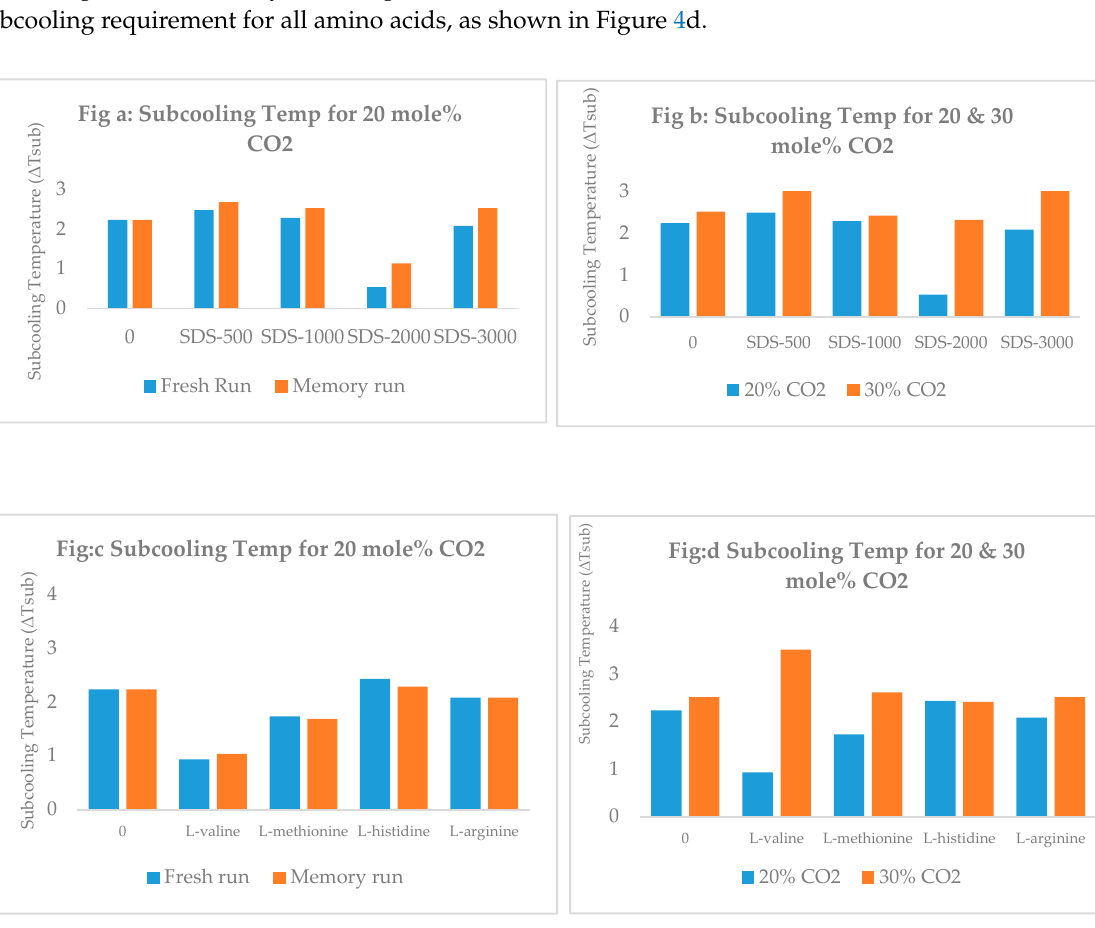
Figure 4. Subcooling kinetics in presence of amino acids and surfactant. Subcooling temperatures at the onset of the flue gas hydrate formation with amino acids and surfactant. ( a ) Subcooling temperature for 20% mole CO 2 for sodium dodecyl sulfate (SDS) at different concentration (fresh and memory). ( b ) Subcooling temperature for 20 and 30 mole% CO 2 for SDS at different concentration (fresh). ( c ) Subcooling temperature for 20% mole CO2 for amino acids at different concentration (fresh and memory). ( d ) Subcooling temperature for 20 and 30 mole% CO 2 for amino acids at different concentration (fresh).